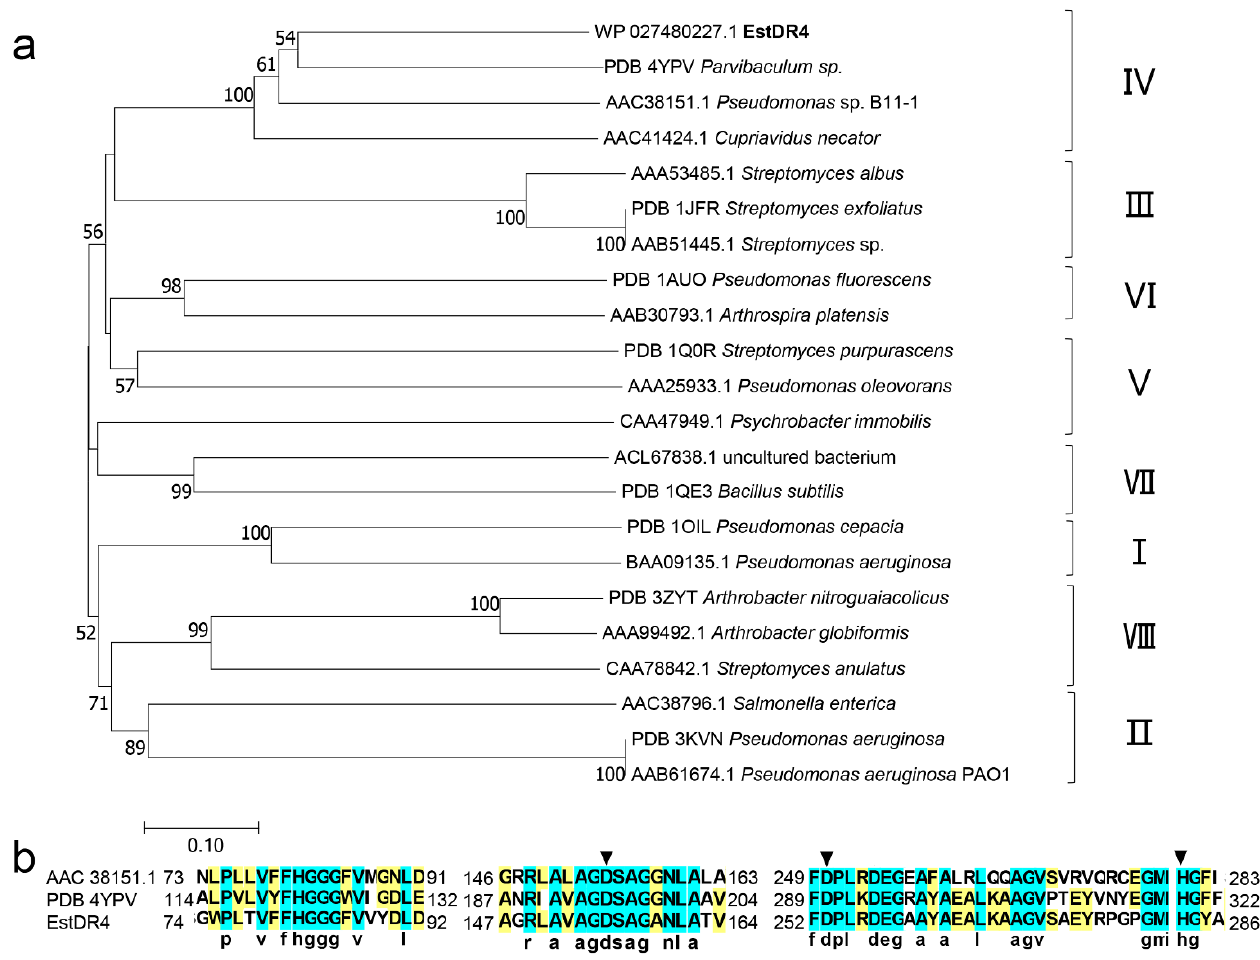
Figure 1. Phylogenetic tree of EstDR4 and homologous sequence alignment. ( a ) Phylogenetic evolutionary tree of EstDR4 constructed using 21 amino acid sequences of lipolytic enzymes from different families and EstDR4. The protein ID at NCBI or the protein databank (PDB) are shown before the name of the strain that was the enzyme source. ( b ) Homologous sequence alignment constructed using the amino acid sequences of EstDR4, Pseudomonas sp. lipase (AAC38151.1), and Parvibaculum sp. esterase (PDB ID 4YPV), which all belong to family IV. The catalytic triads are marked by black arrows.